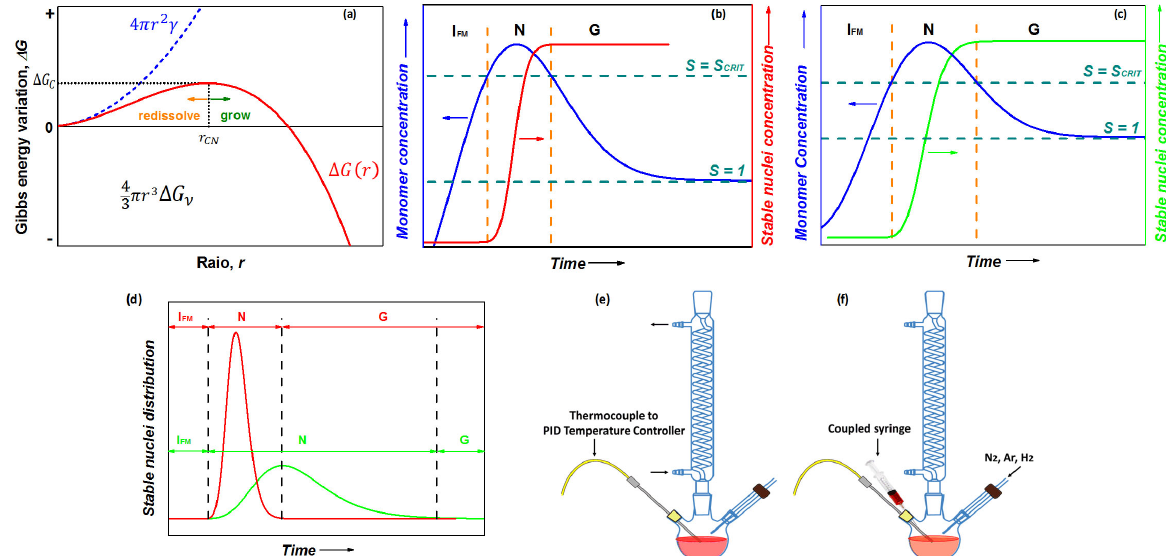
Figure 1 - ( a ) Schematic Gibbs energy of nucleation and growth processes showing the “critical” behavior. Classical LaMer model diagrams of nucleation and growth according to the time-dependence of monomer and stable nuclei concentrations at ( b ) fast and ( c ) slow nucleation process in two monomer supersaturation conditions. ( d ) Time-dependence of stable nuclei uniformity distribution related to schematic diagrams in (b) and (c). Experimental apparatus using in the synthesis procedures of ( e ) modified polyol process and thermal decomposition and ( f ) the hot-injection